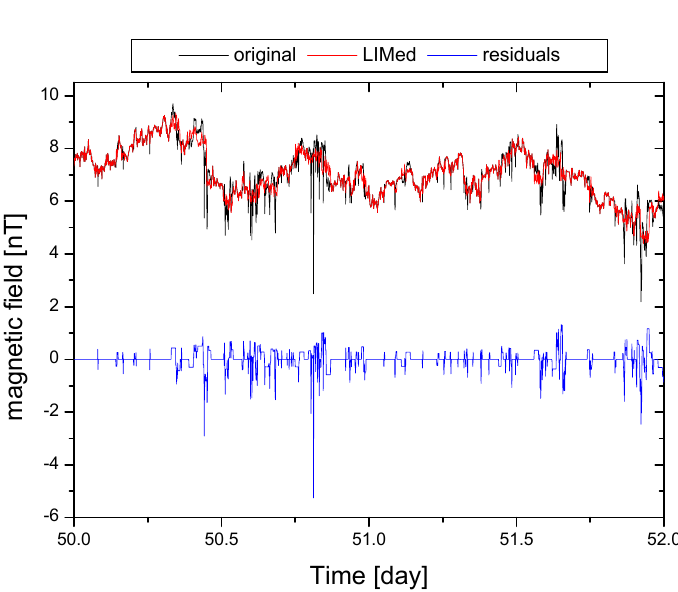
Figure 117: The black curve indicates the original time series, the red one refers to the LIMed data, and the blue one shows the difference between these two